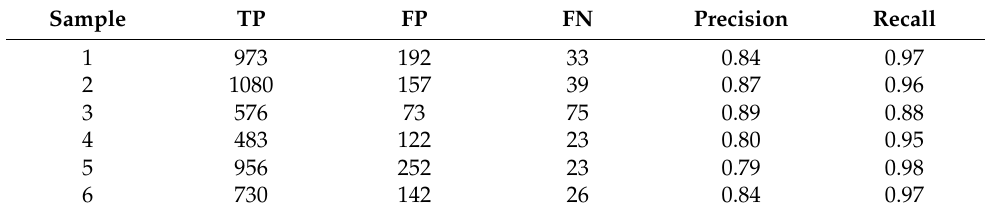
Figure 3. Extracted polygon mask of penguin pixels and contour lines from the UAV image and digital elevation model on Inexpressible Island in the Ross Sea, Antarctica on 19 January 2018. Table 3. Accuracy assessment of penguin-pixel extraction